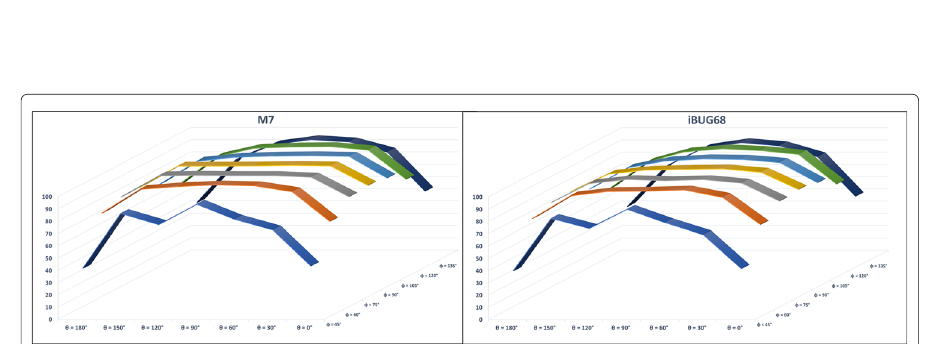
Fig. 13 3DSTN: camera position varying across φ (from 45 ◦ to 135 ◦ ) and θ (from 0 ◦ to 180 ◦ )